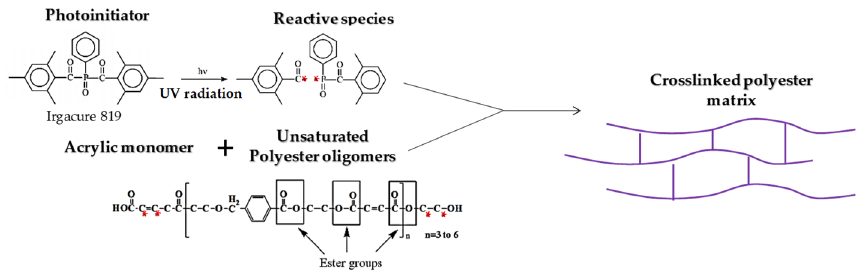
Figure 1. Schematic representation of the chemical reaction in the UV radiation curing process.